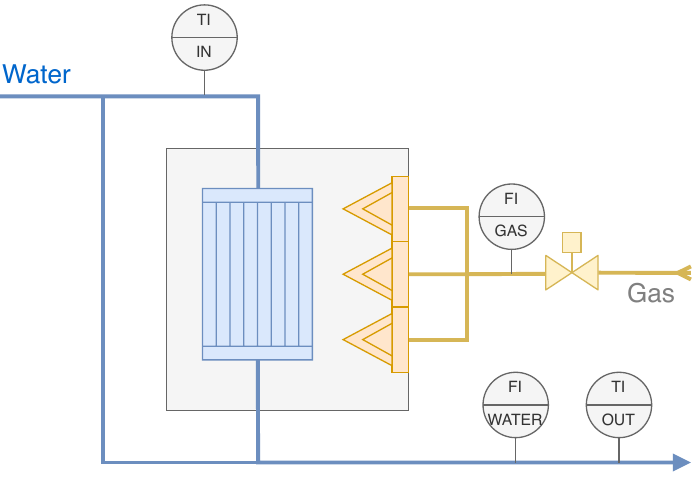
Figure 6. The process diagram of the considered industrial plant—the KVGM-100 boiler in the configuration for district heating whereby the passing water is heated with